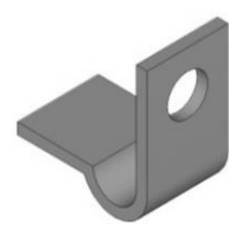
Figure 5. An original 3D model.